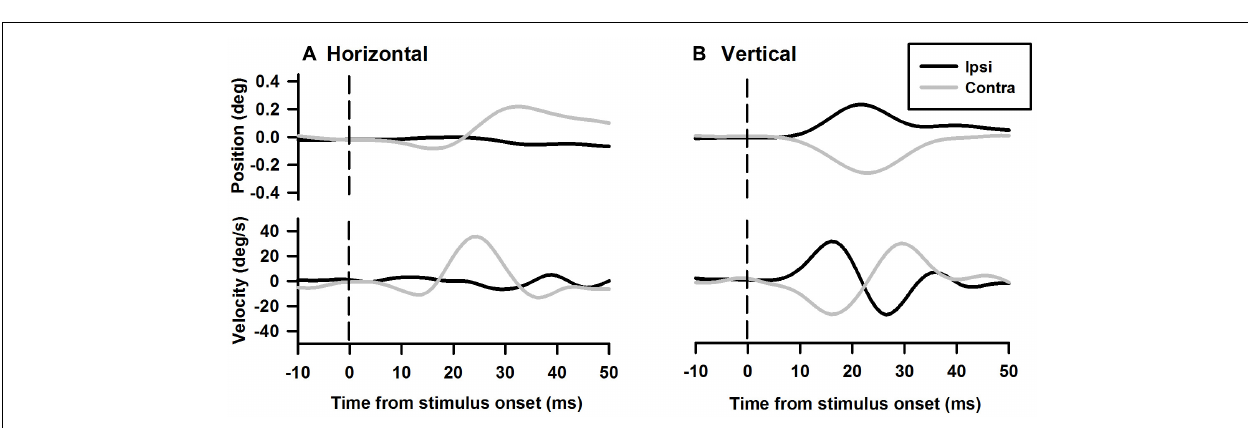
FIGURE 9 | Representative eye movement responses to tone bursts of 1,000 Hz. (A) Tone-evoked horizontal eye movement responses in position ( upper panel ) and velocity ( lower panel ). (B) Tone-evoked vertical eye movement responses in position and velocity ( lower panel ).